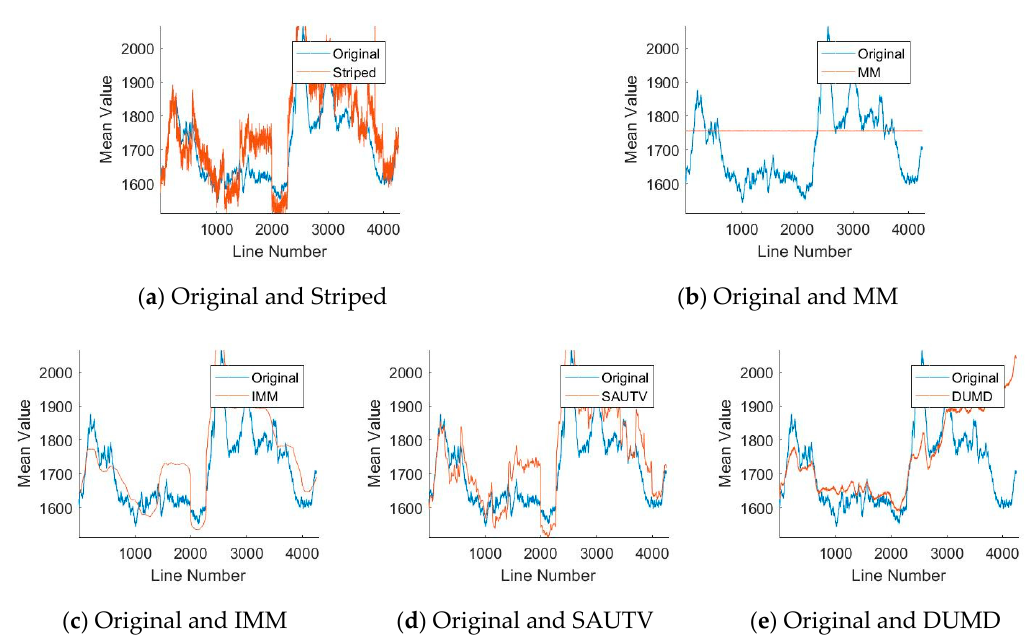
Figure 7. CMVs of Data 4 (GF-1D). Where ( a ) is the CMVs of original image and striped image, ( b ) is the CMVs of original image and MM-processed image, ( c ) is the CMVs of original image and IMM-processed image, ( d ) is the CMVs of original image and SAUTV-processed image, ( e ) is the CMVs of original image and DUMD-processed image.